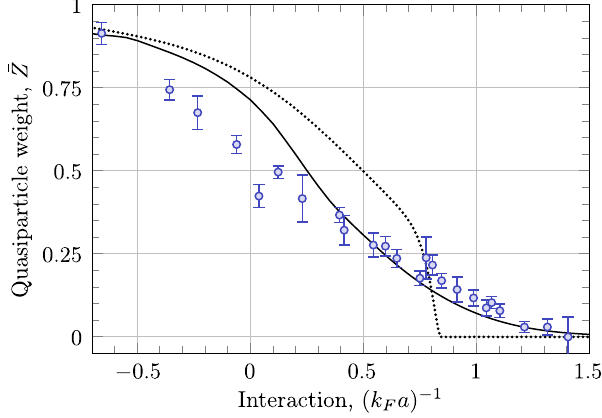
FIG. 5. Measured quasiparticle weight. The quasiparticle ¯ Z weight is shown for different interaction strengths. Blue circles mark the weight extracted from the Raman spectra by identifying the nearly symmetric spectral line shape arising from the coherent ¯ Z polaron contribution. is smoothly decreasing toward the polaron-molecule transition, in agreement with our theoretical prediction, averaged over the harmonic trap using the LDA (solid line). For comparison, we also present the trap-averaged pre- diction for a single impurity at T ¼ 0 (dotted line) obtained from Ref. [38].